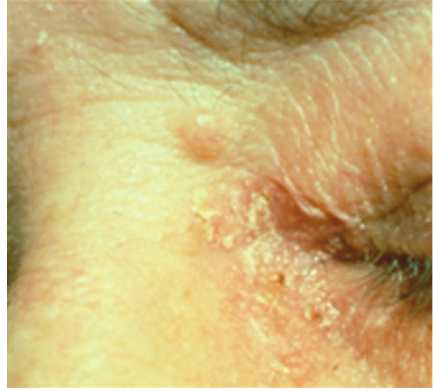
Figure 1: Sebaceous carcinoma of eyelid found during routine screening of a patient with Muir-Torre